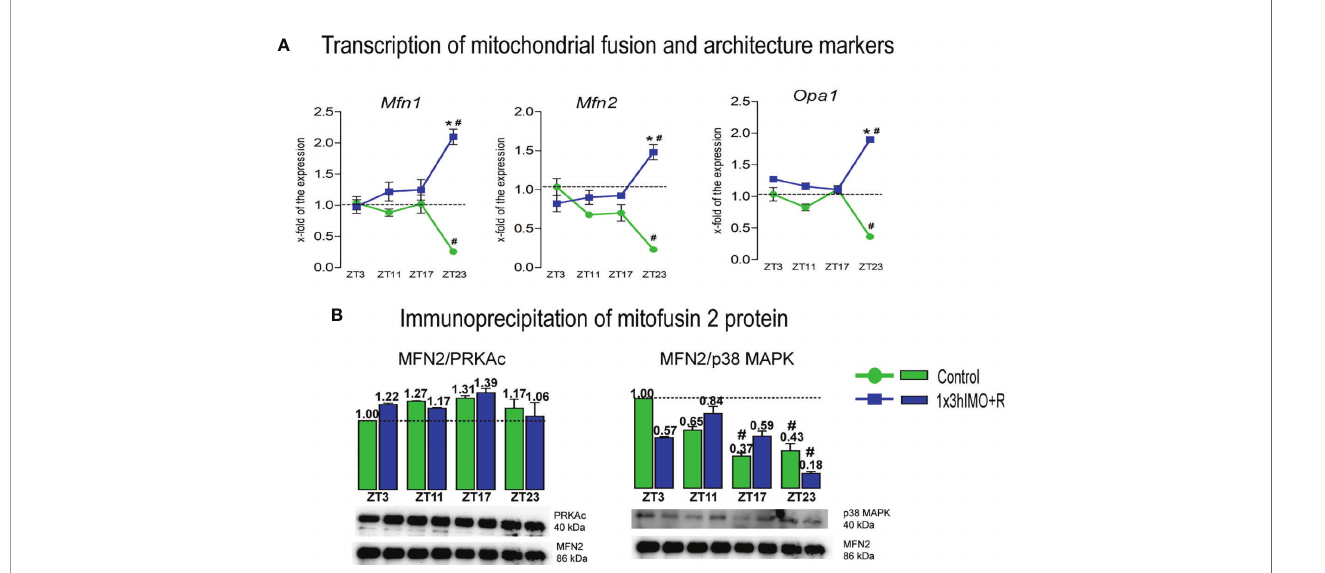
FIGURE 4 | Transcription of mitochondrial fusion and architecture markers, as well as interactions of mitofusin 2 protein and PRKAc and p38 MAPK proteins are signi fi cantly changed in spermatozoa of acutely stressed adult rats in a time-dependent manner. Isolated RNA from spermatozoa of undisturbed and stressed rats was used for the analysis of the transcriptional pro fi le of markers of mitochondrial fusion and architecture (A) . Isolated proteins from spermatozoa of undisturbed and stressed rats were used for immunoprecipitation analysis with MFN2 antibody, followed by Western blot for PRKAc and p38 MAPK (B) . The representative blots are shown as panels. Data from scanning densitometry were normalized on MFN2 (internal control). Values are shown as bars above the photos of blots. Data are presented as green dots connected with a green line or green bars for the control group, and blue squares connected with a blue line or blue bars for the 1x3hIMO group, and are mean ± SEM values of two independent in vivo experiments. Statistical signi fi cance was set at p < 0.05: * vs. the control group of the same time point, # vs. the control group of ZT3 time